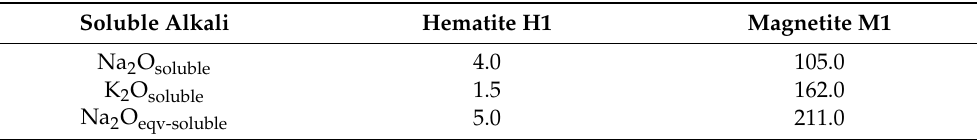
Table 3. Water soluble alkali content in high-density aggregates containing iron ore according to ASTM C114-13 [20] in